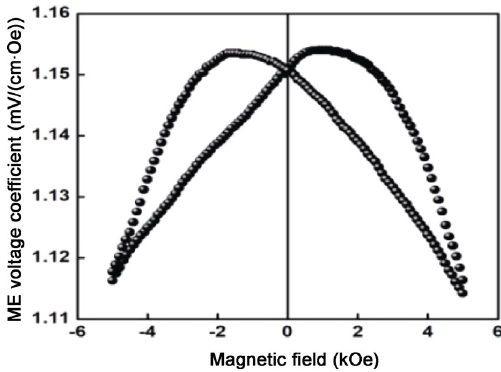
Fig. 11 ME voltage coefficient with the applied DC magnetic